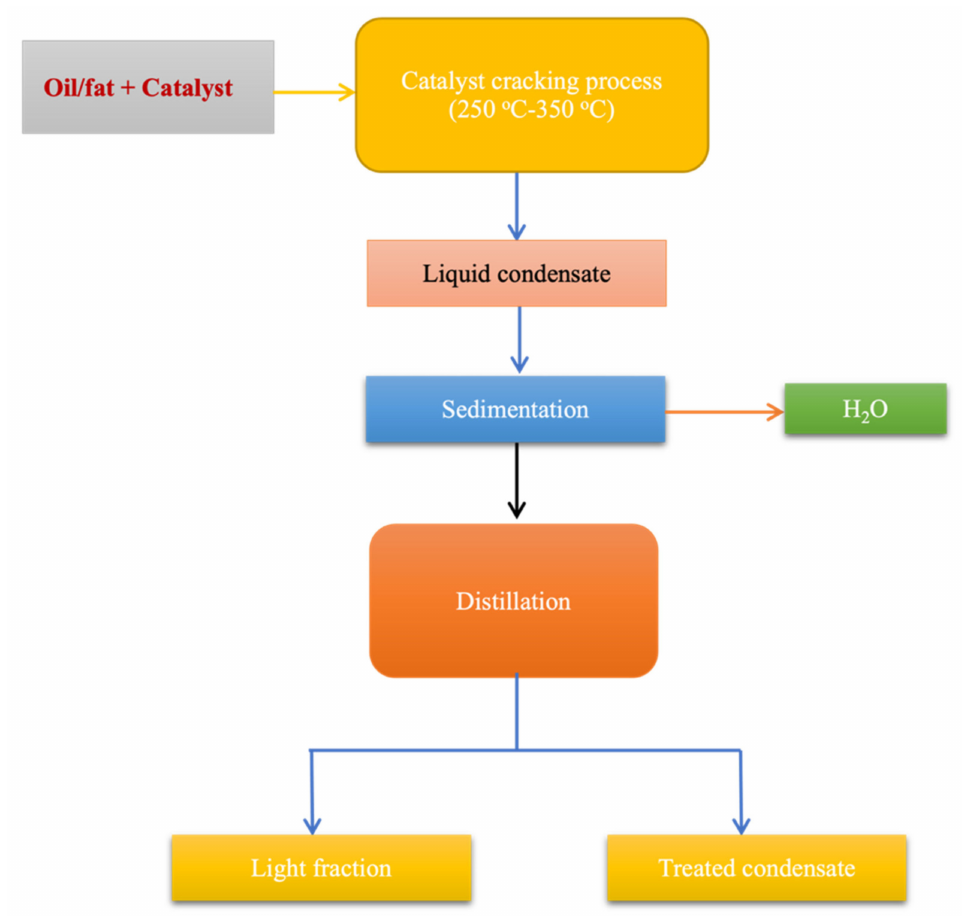
Figure 2. Flow chart representing the process of thermal cracking or